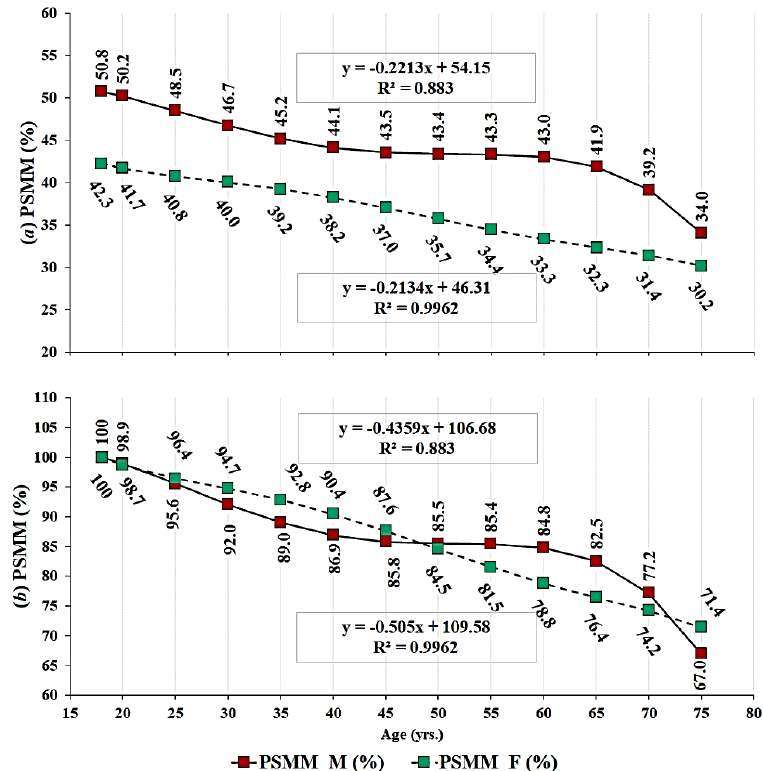
Figure 2. Gradually lower PSMM values across age groups presented in obtained ( a ) and normalized ( b )